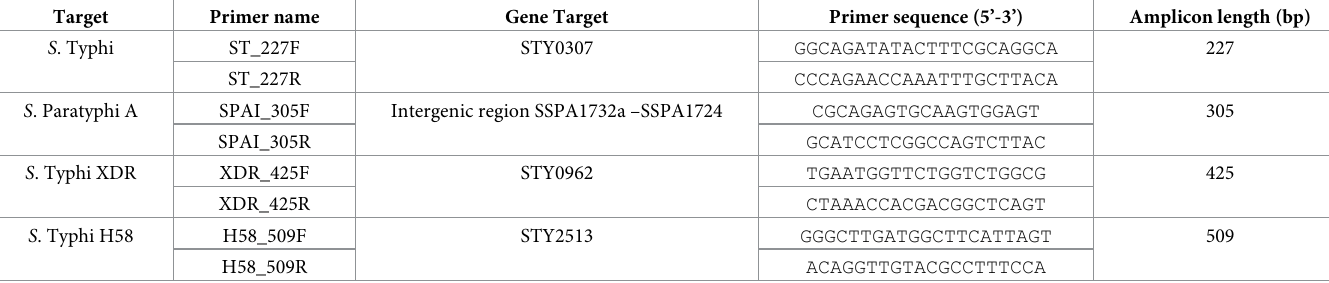
Table 2. Primer sequences used in our multiplex assay with expected amplicon sizes generated for each target. Target